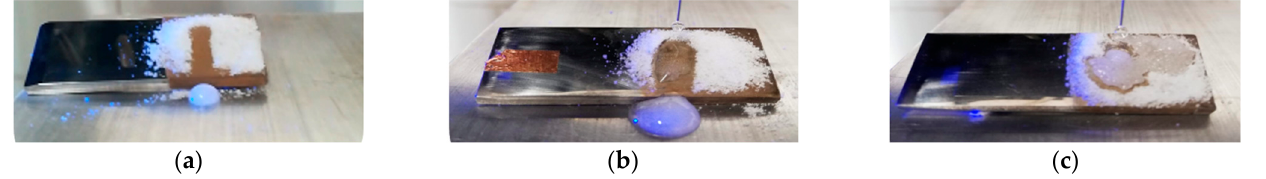
Figure 5. Self-cleaning test for SS samples treated in ( a ) DMSO-containing solution and in ( b ) ethanol-containing solution. ( c ) Self-cleaning test of the SS sample treated in ethanol-containing solution with an electrodeposition time of 20 s.